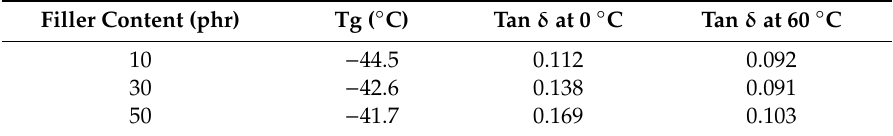
Table 4. DMA measurement results of the mFD / NR composites with di ff erent filler